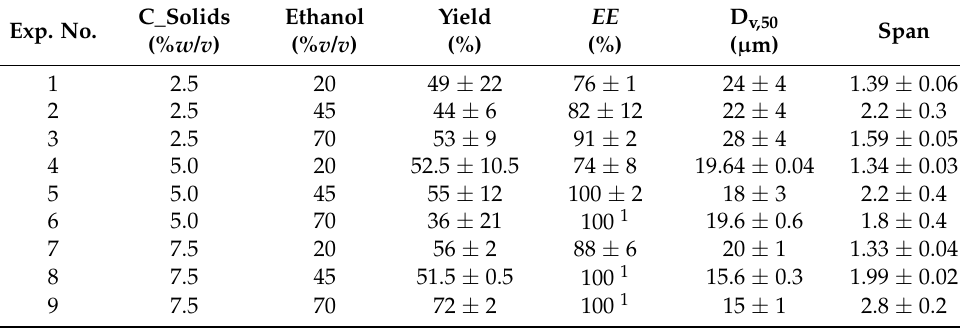
Table 1. SASD-processed RSV–DPF results following the 3 2 full factorial design. Exp.